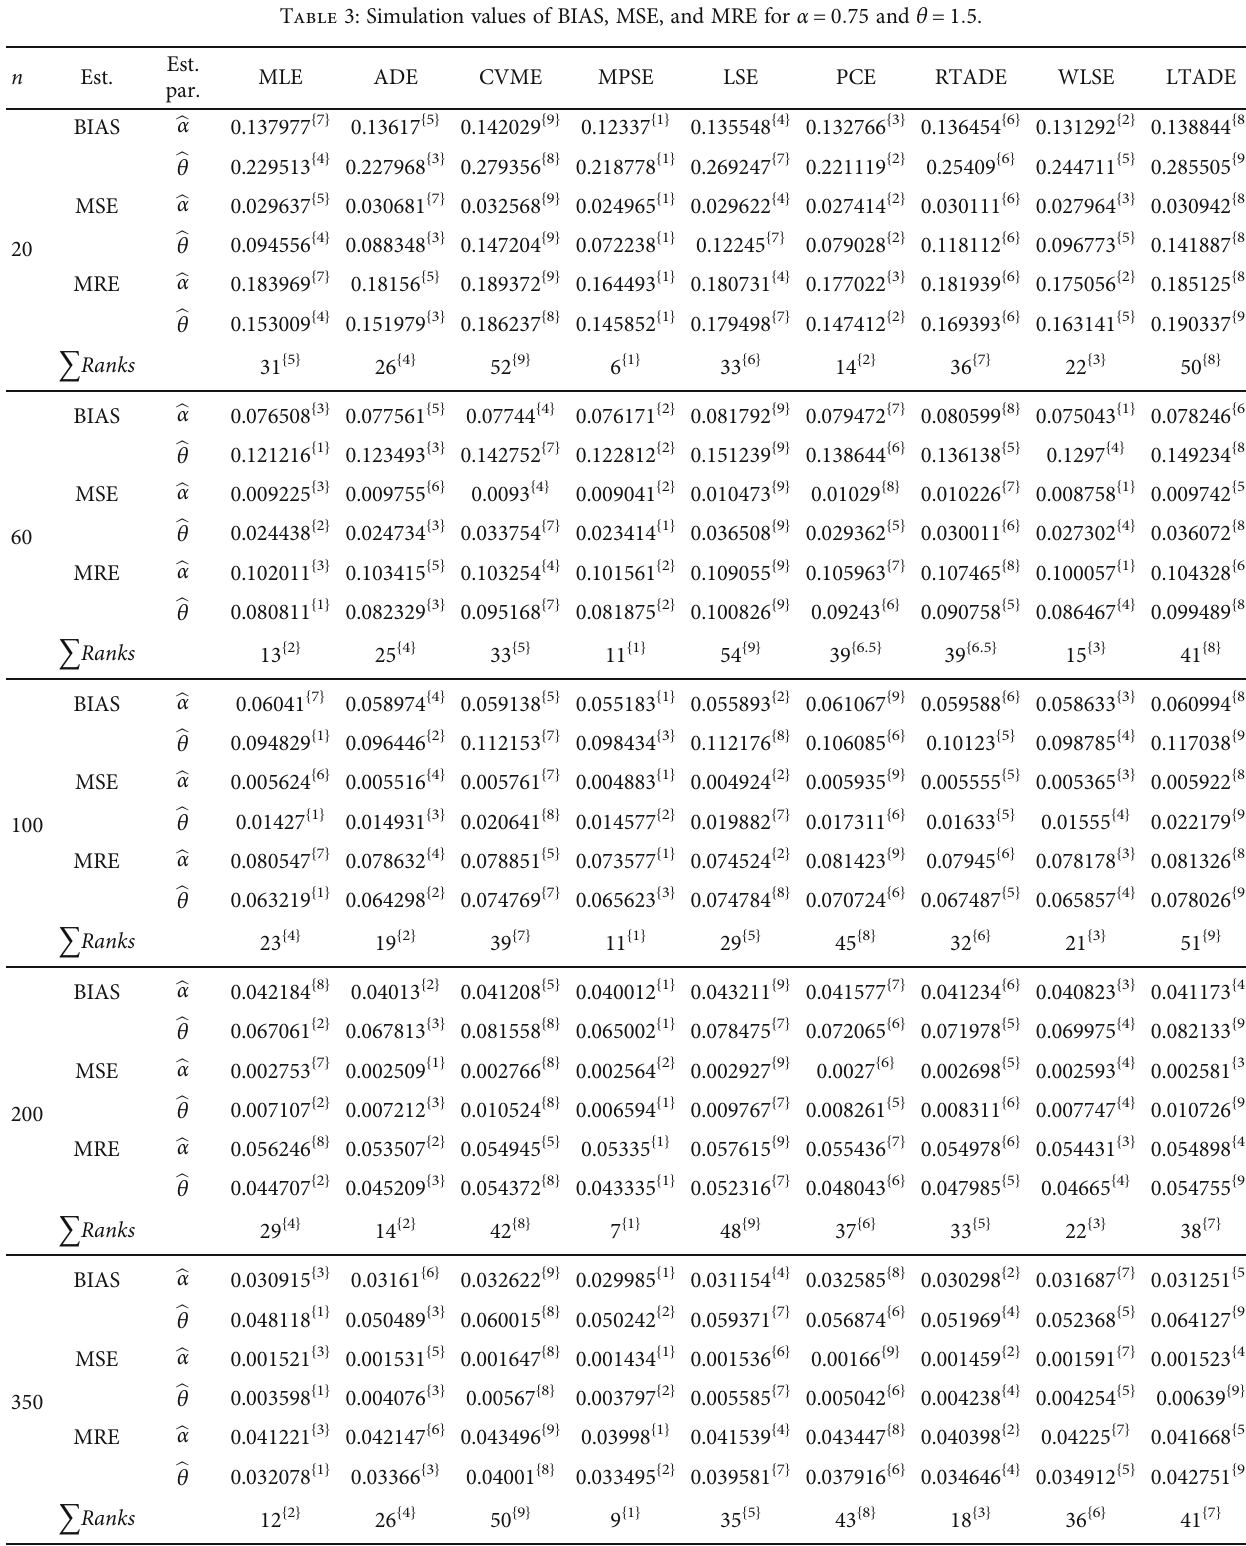
Table 3: Simulation values of BIAS, MSE, and MRE for α = 0 : 75 and θ = 1 : 5